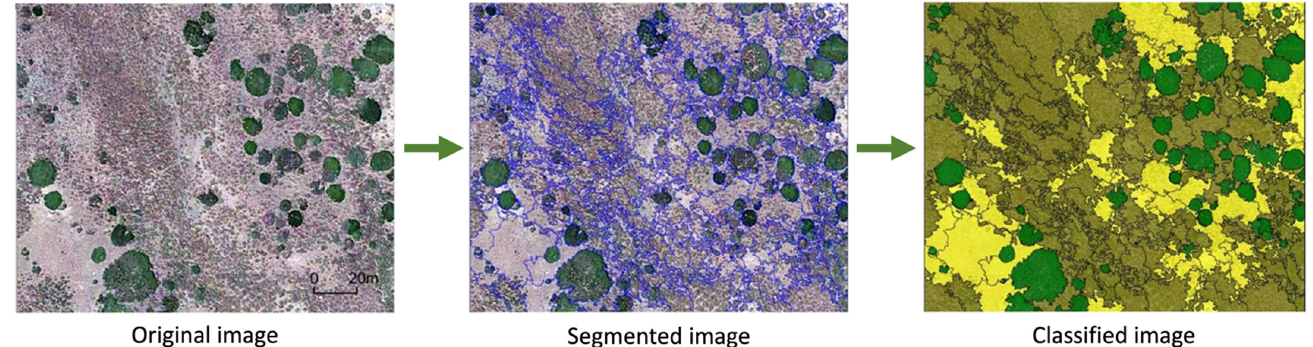
Figure 2. The two main steps of object-based image analysis (OBIA). (1) The segmentation consists of dividing groups of pixels with similar spectral properties and relationships to their context. (2) The classification of these objects into classes of interest is performed based on similarities in shape, spectral, and contextual information.